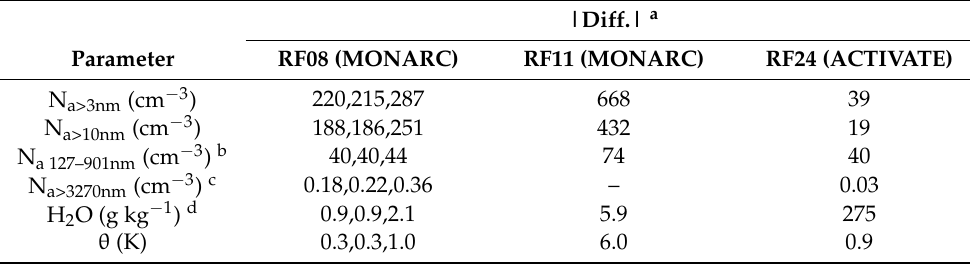
Table 6. The differences in leg-mean values for selected variables between Min. Alt. and BBL or BCB for special cases shown in Figure 6. Leg pairs closest in time to the soundings were selected for the comparisons. “–” refers to insufficient data available. For RF08, three BBL legs were conducted and the corresponding numbers are shown in the parentheses in order (left to right) from BBL1 to BBL3. |Diff.| a Parameter RF08